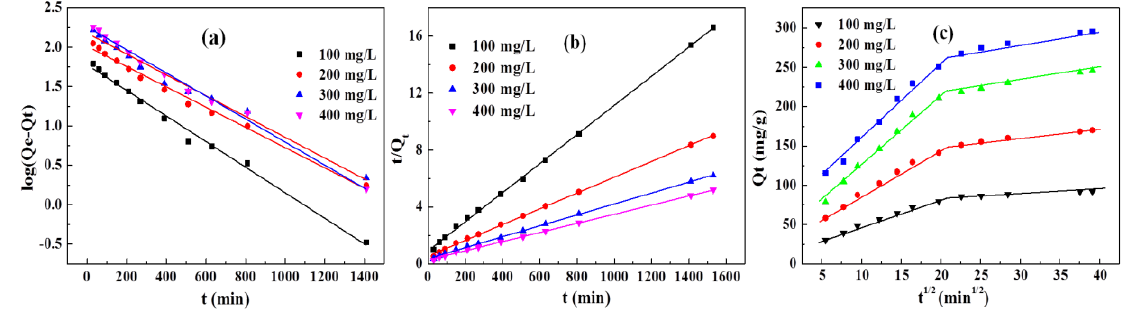
Figure 9. ( a ) Pseudo-first-order plots, ( b ) pseudo-second-order plots, and ( c ) intraparticle diffusion plots for MB adsorption.